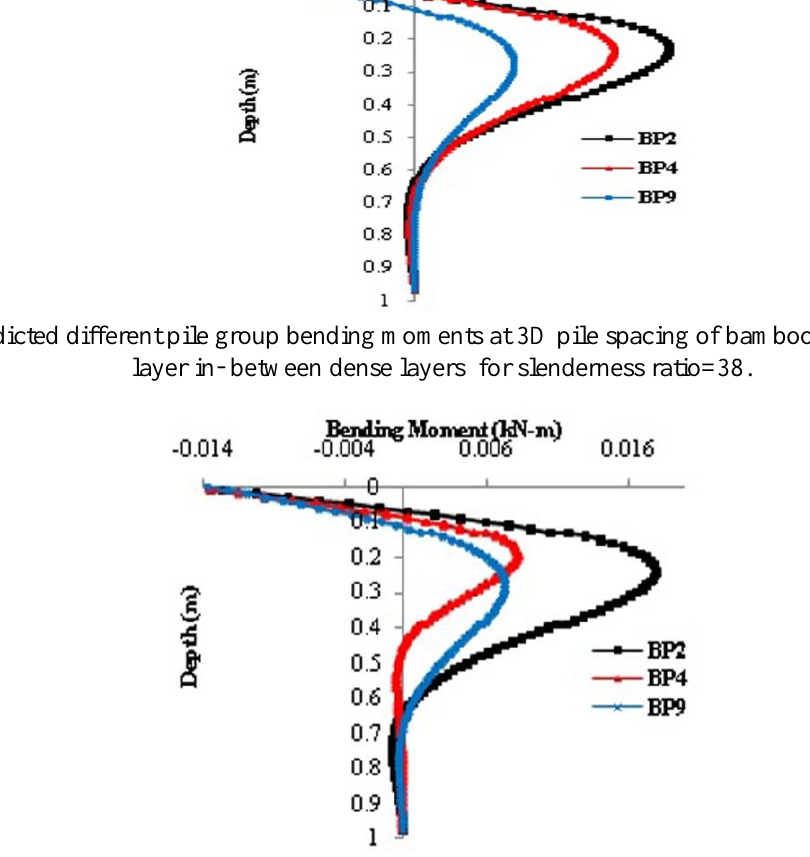
Fig. 15. Predicted different pile group bending moments at 3D pile spacing of bamboo pipe piles in dense sand layer in-between layer for slenderness ratio as